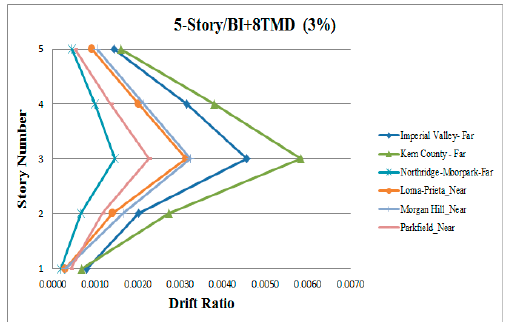
Figure A31. Drift ratios for 5-story base-isolated building with 8 TMDs.